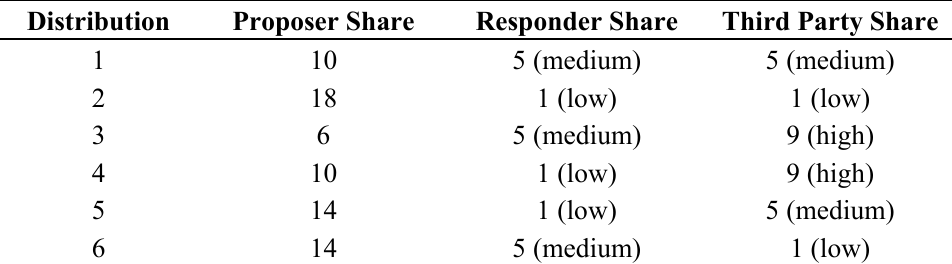
Table 3. Distributions of offers available to the proposer to share an endowment of 20 Euros (textual labels as used in the